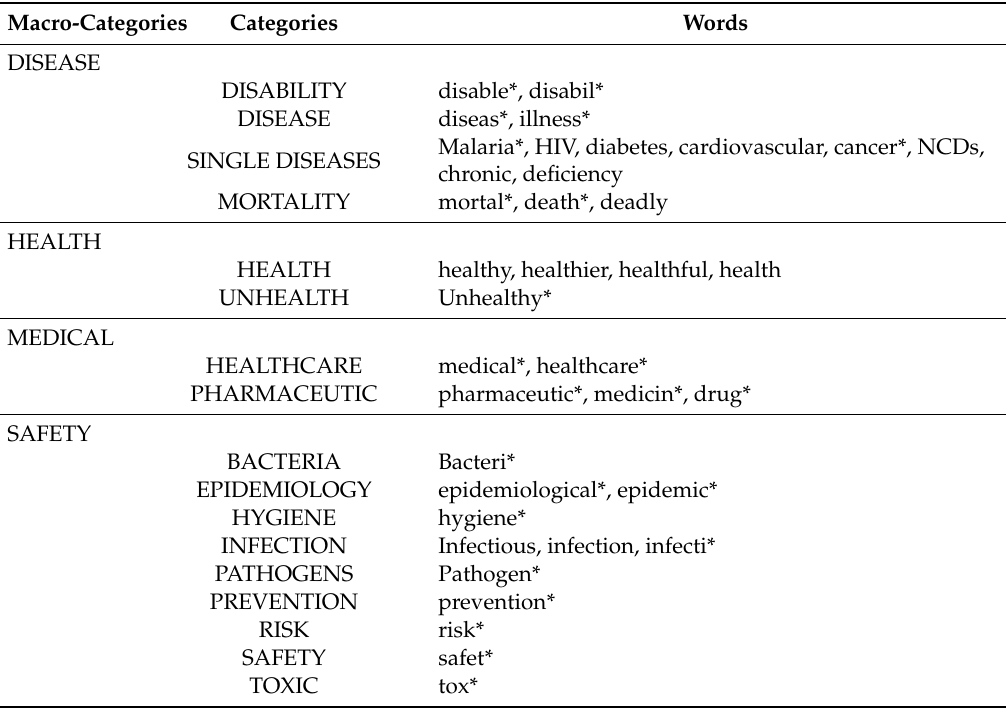
Table A1. Dictionary of Health dimension: Macrocategories, categories,